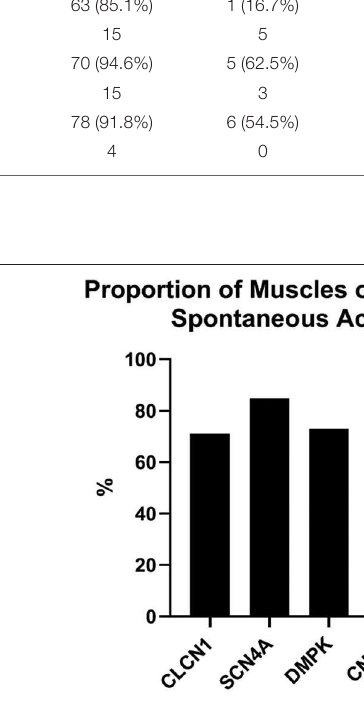
FIGURE 2 | Proportion of muscles on EMG with abnormal spontaneous activity by genotype.